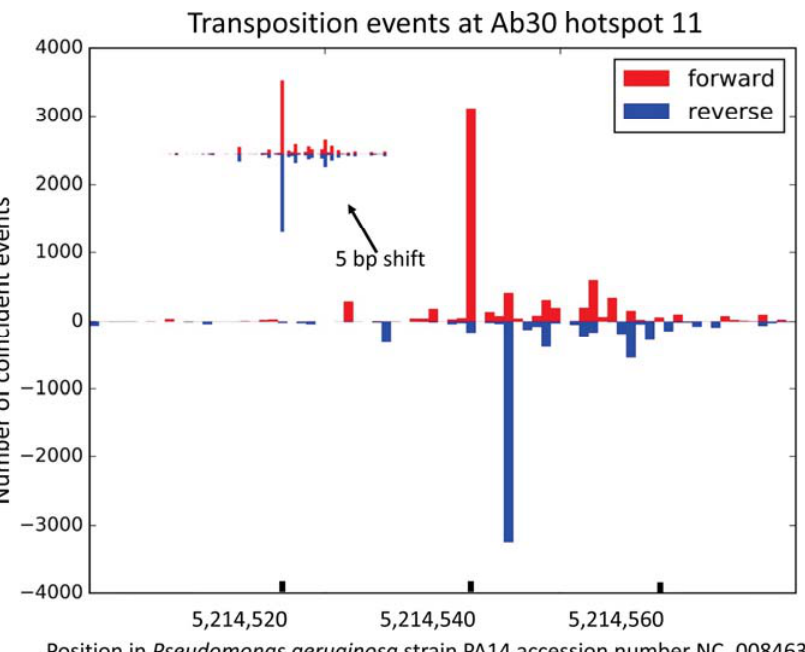
Figure 3. A focus on Ab30 hotspot 11. The position of the transposition events is shown at a one base ‐ pair resolution. Insertions in the forward or reverse orientations are presented in the red or blue colors, respectively. The small inset is obtained by a five base ‐ pairs shift of the upper part of the graph. The almost perfect symmetry illustrates the absence of bias in transposition orientation.